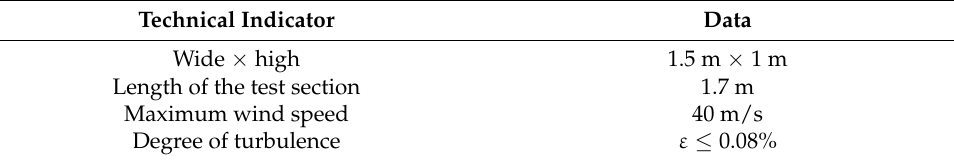
Table 1. Main technical indicators of the wind tunnel.